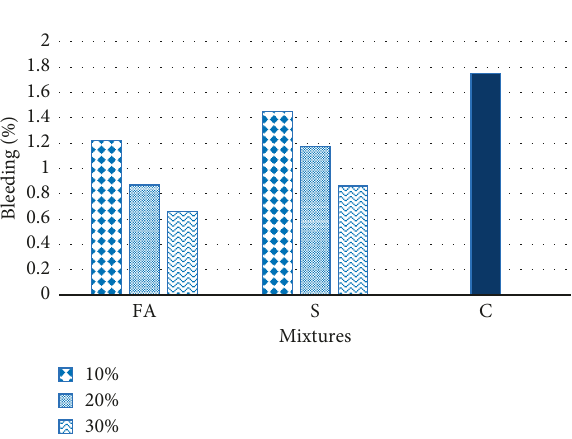
Figure 5: Flowability test results.